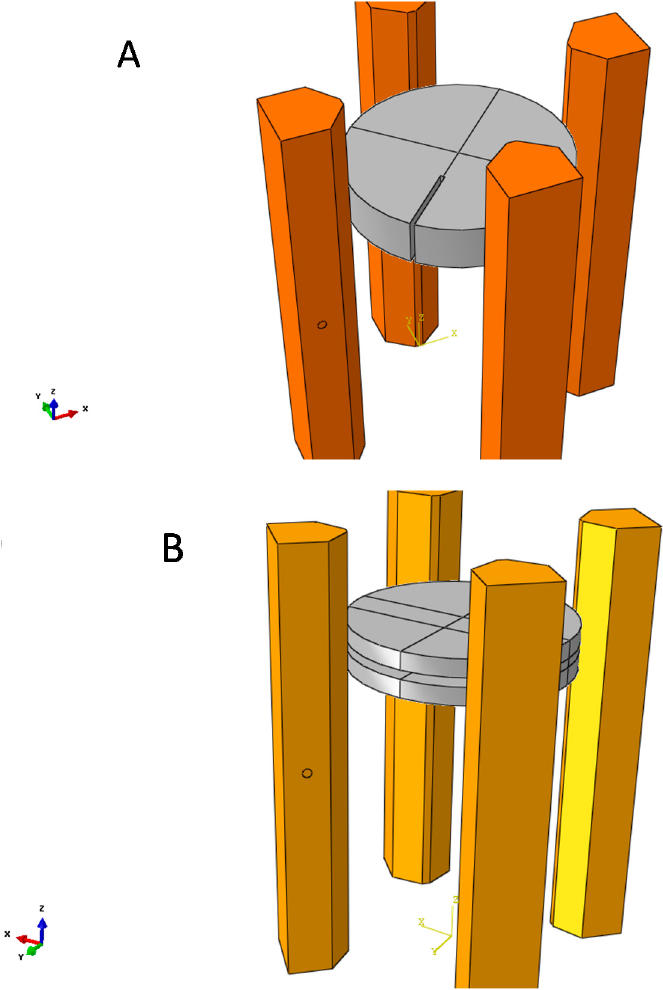
Figure 10. CAD (Computer-Aaided Design) model used for the finite element method (FEM) and the VdP method, ( A ) radial crack, placed between the probes; ( B ) transverse crack.